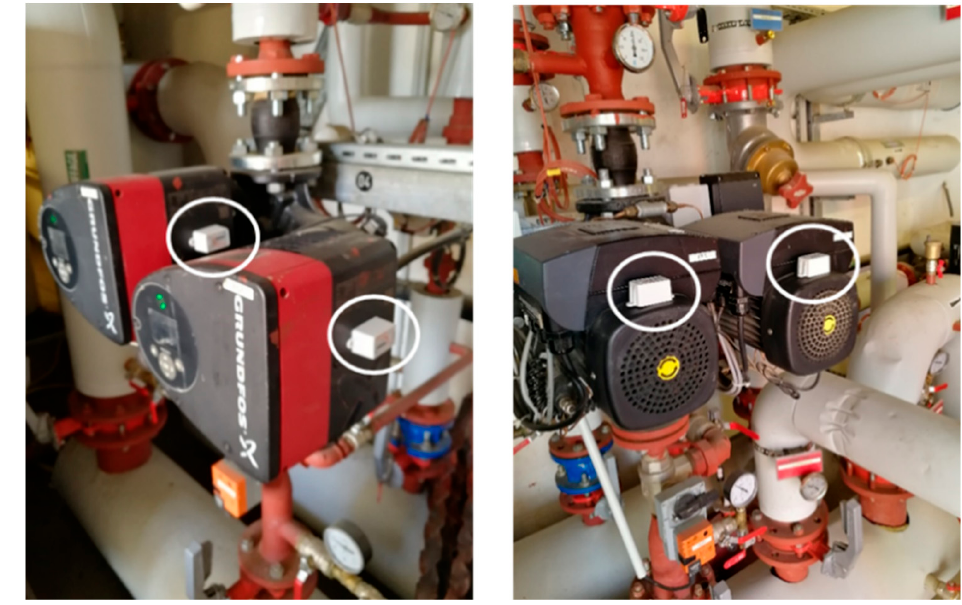
Figure 5. A photo of a vibration device installed on a double pump.